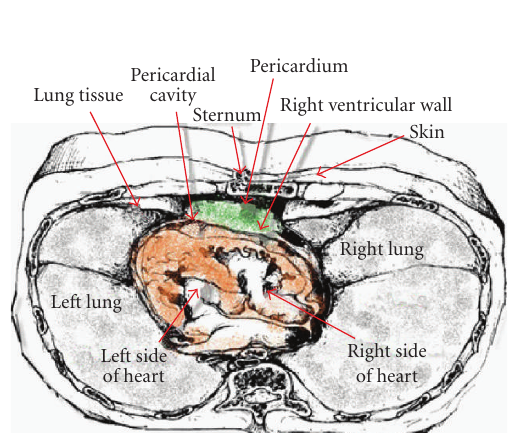
Figure 2: Radar-based MCG signal processing methodology.